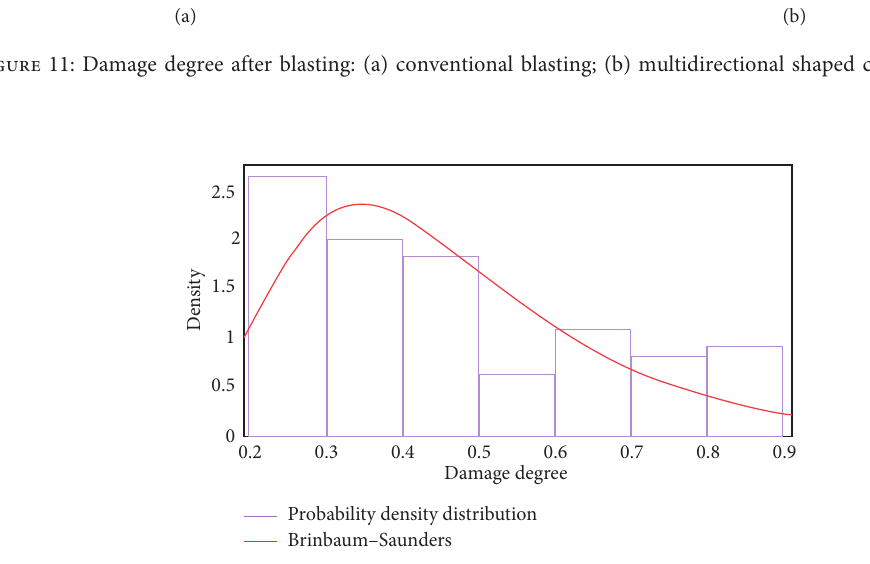
Figure 12: The probability density histogram and fitting curve of damage degree by conventional blasting.